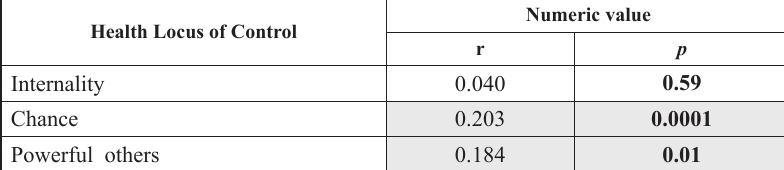
Table 7. Data Obtained from Analysis of Correlation between Health Locus of Control and Negative Attitude towards Remote